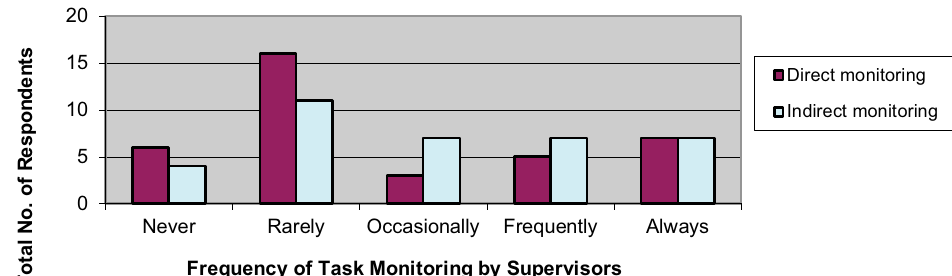
Figure 4. Reported frequency of task supervision in reintroduction